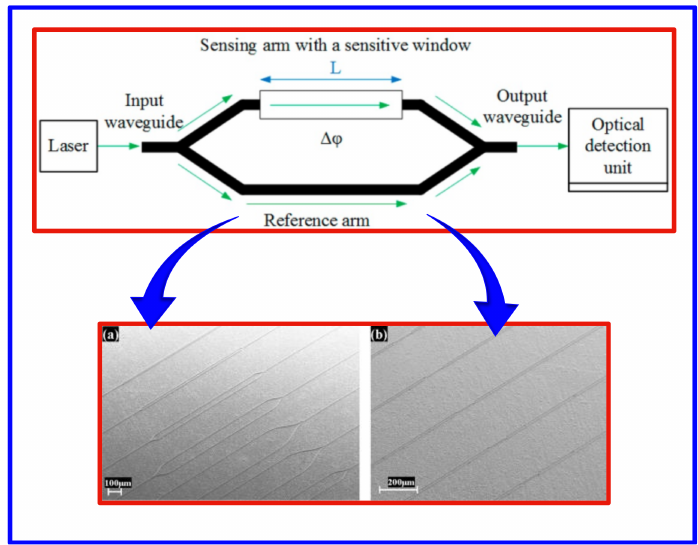
Figure 10. The typical configuration of the MZI structure consists of two waveguides (input and output), a beam splitter (the left Y-function), and a beam combiner (the right Y-function), as well as two straight waveguides between the two Y-functions as the sensor and the reference arms [198]. SEM images illustrate ( a ) a set of MZI ridge interferometer structures and ( b ) a set of ridge coupler structures. Adapted with permission from [199].Copyright 2014 © AIP